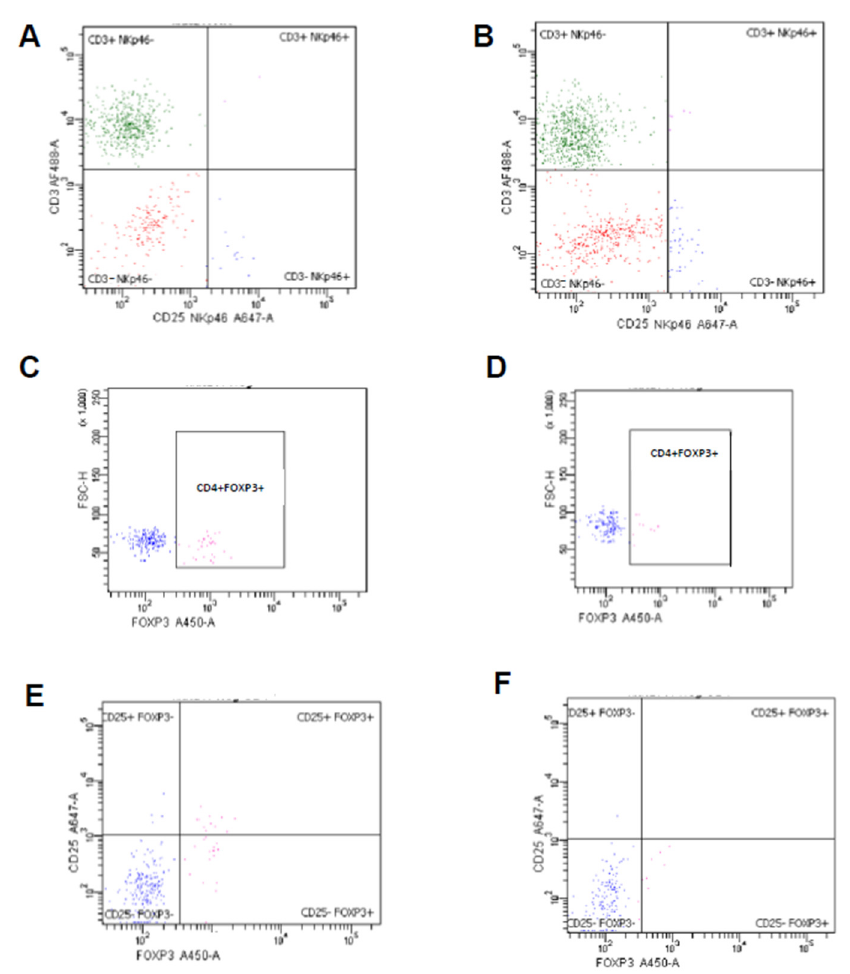
Figure 3. Representative images of endometrial lymphocytes expressing markers specific for NK cells and regulatory T cells (Tregs). Phenotype of endometrial lymphocytes isolated from mares in estrus ( A , C , E ) and diestrus ( B , D , F ). Lymphocytes were labeled with anti-equine CD3 and NKp46 monoclonal antibodies ( A , B ). For Tregs, cells were labeled with anti-equine CD4, anti-mouse FOXP3 monoclonal antibody ( C , D ) and additionally CD25 monoclonal antibody ( E , F ). Plots show cells gated on lymphocytes ( A , B ) and lymphocytes and CD4+ cells ( C – F ).